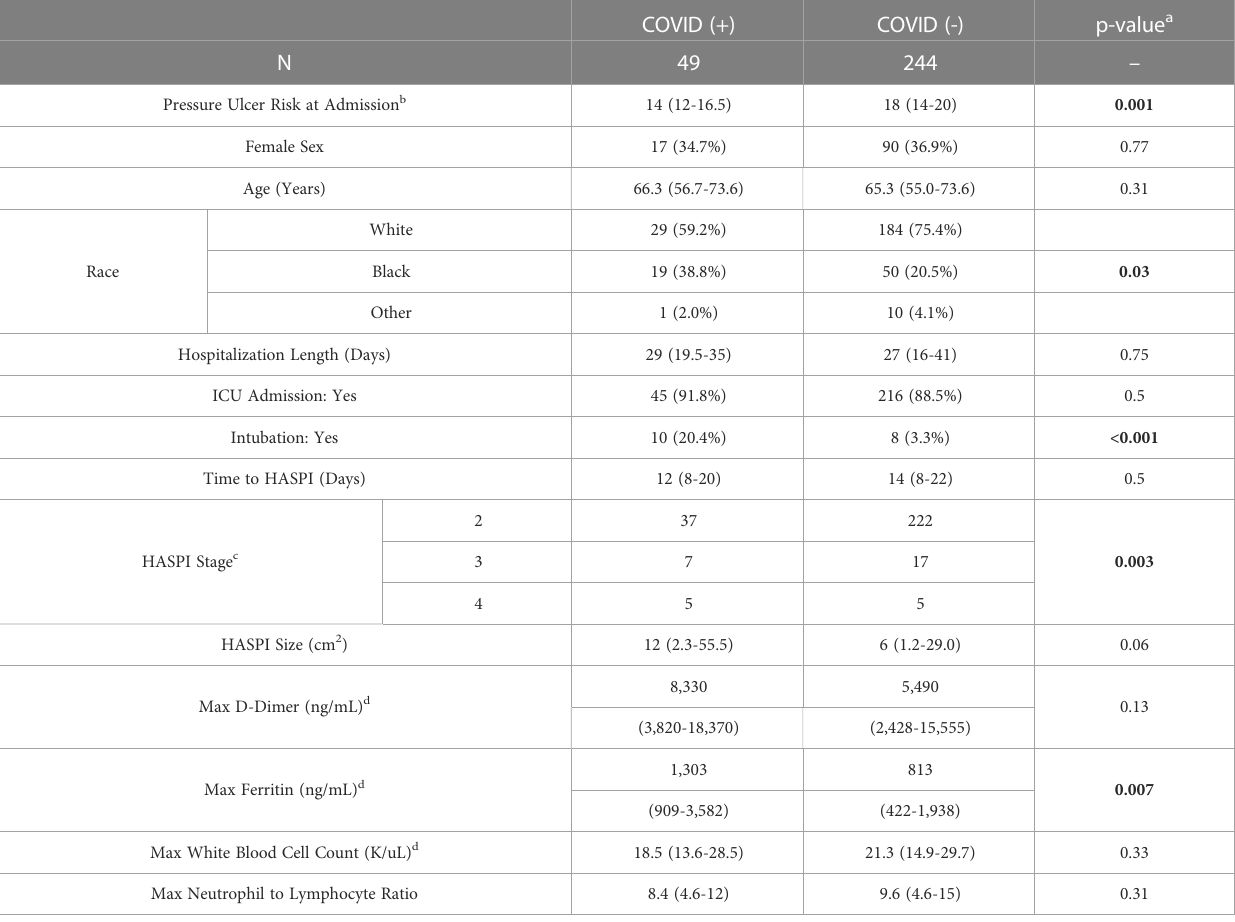
TABLE 1 Clinical and Demographic characteristics of hospitalized patients who developed HASPIs.